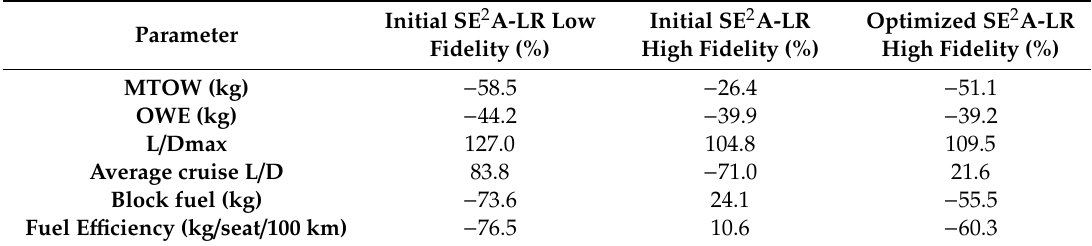
Table 9. Comparison of relative changes in key aircraft parameters with respect to